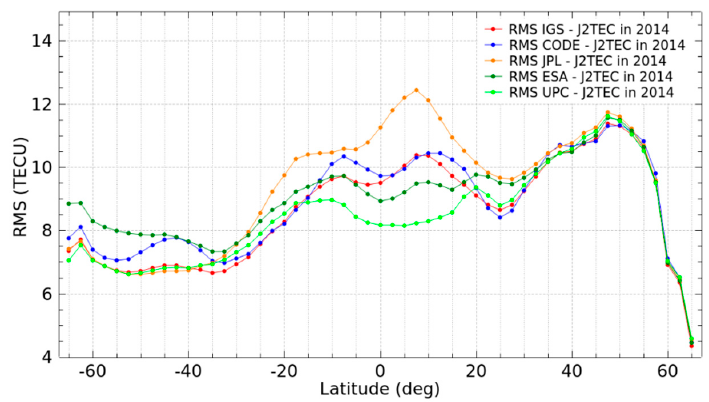
Figure 13. Bias values for comparison between IGS GIMs or IAAC products and J2TEC in 2014.